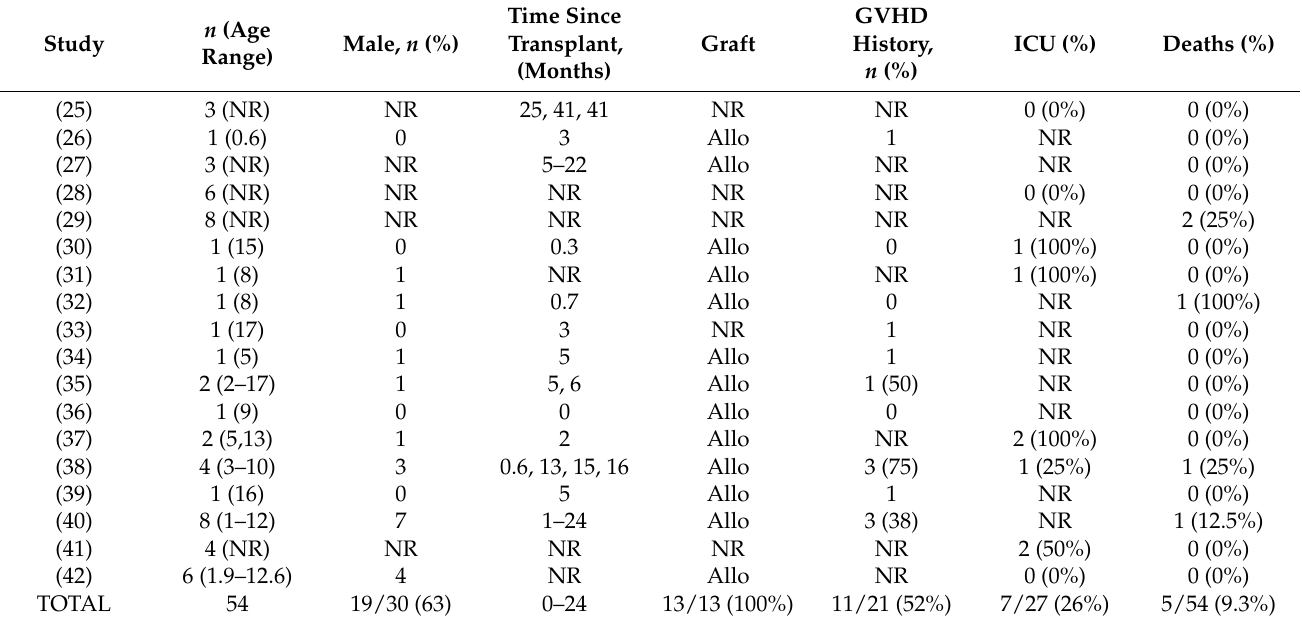
Table 2. Summary of the studies describing pediatric patients with COVID-19 following